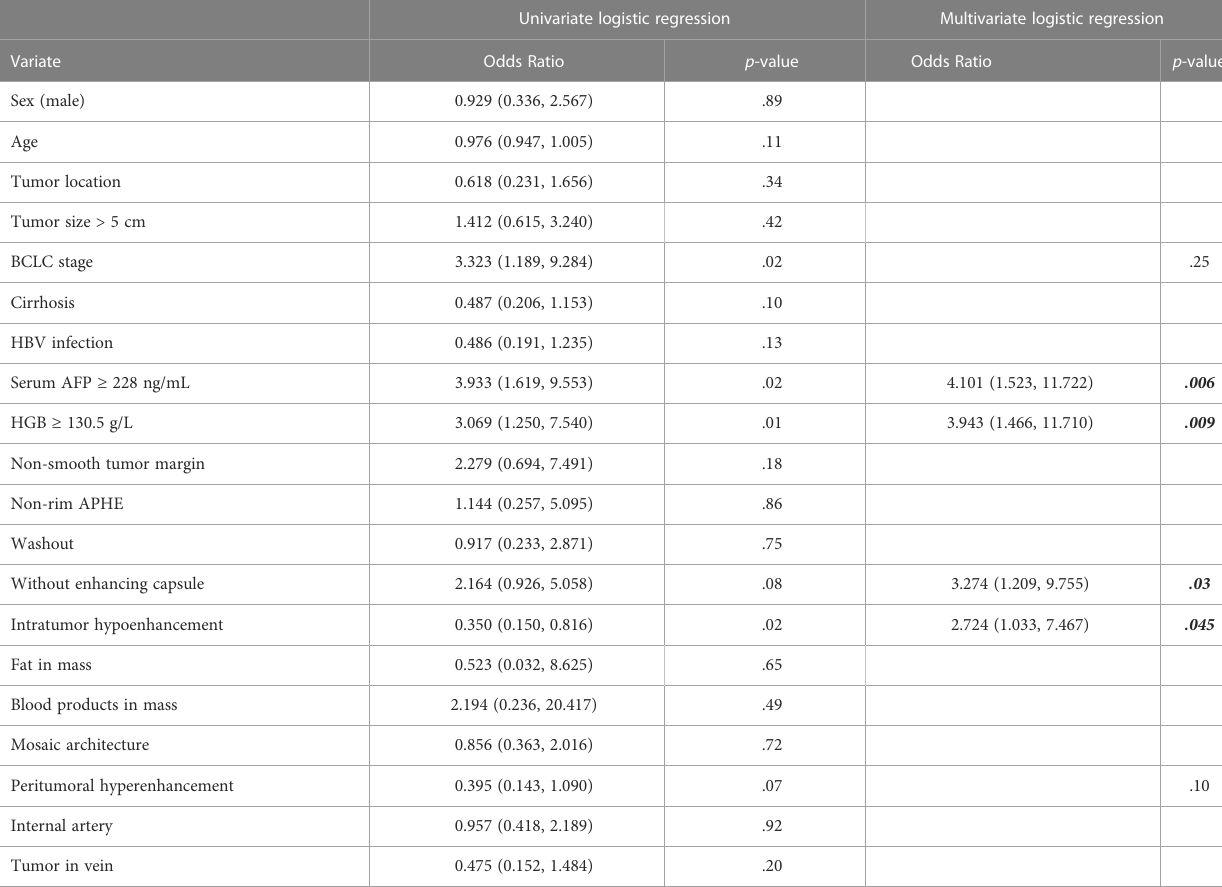
TABLE 4 Univariate and multivariate analyses of clinical and imaging features for